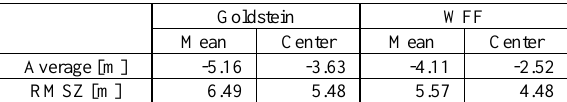
Table 5. Accuracy of Building Height